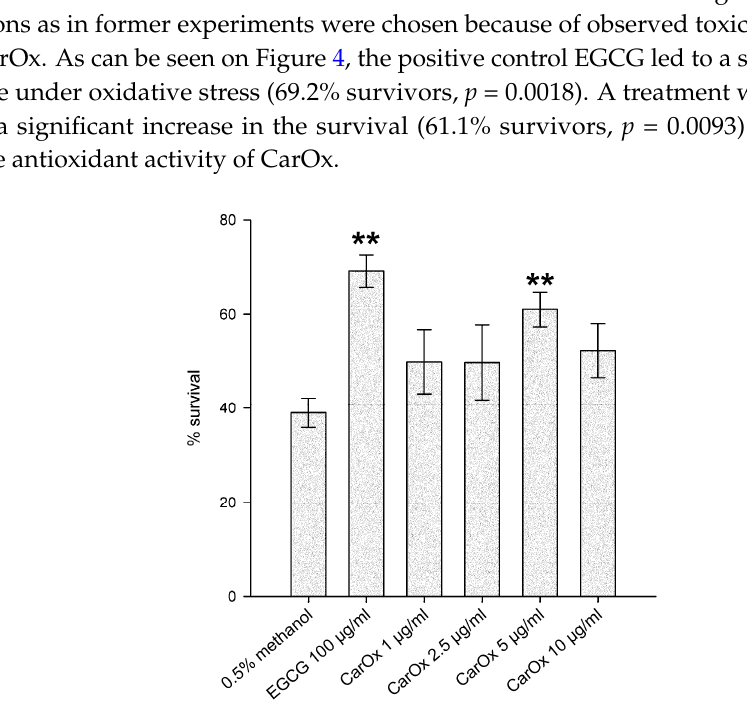
Figure 4. Survival assay in C. elegans . The worms were treated with indicated substances prior to subjecting them to lethal oxidative stress induced by 80 μ M juglone. ** p < 0.01 compared to the negative control (methanol).